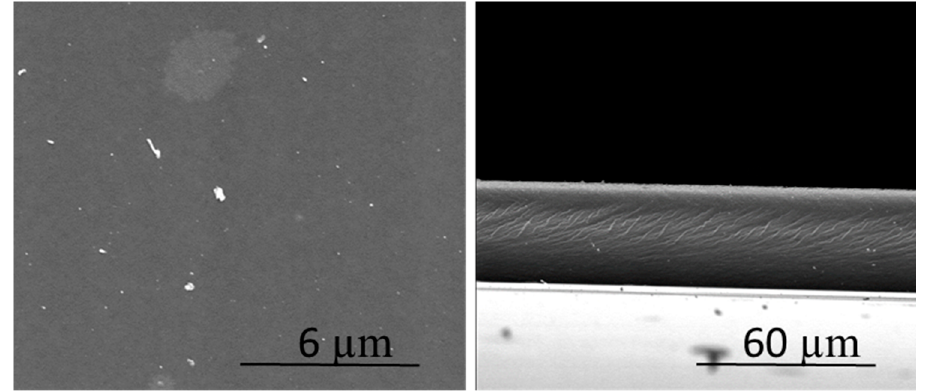
Figure 1. SEM images of a PIM with a composition of 50% CTA, 30% THTDPCl, and 20% NPOE. ( Left ) surface; ( right ) cross ‐ section.